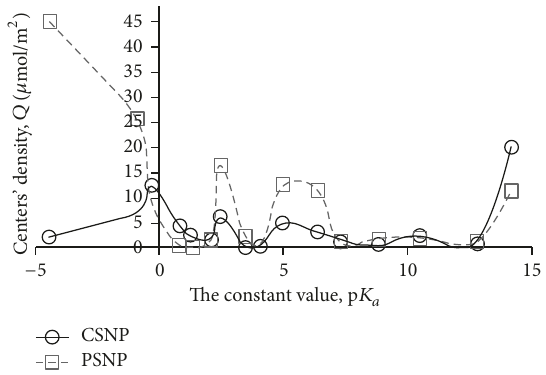
Figure 1: Distribution of adsorption centers on the nanoparticle